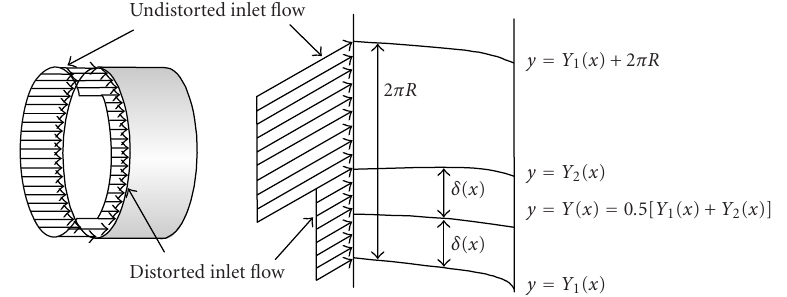
Figure 1: The distorted inlet flow and its two-dimensional schematic used for integral